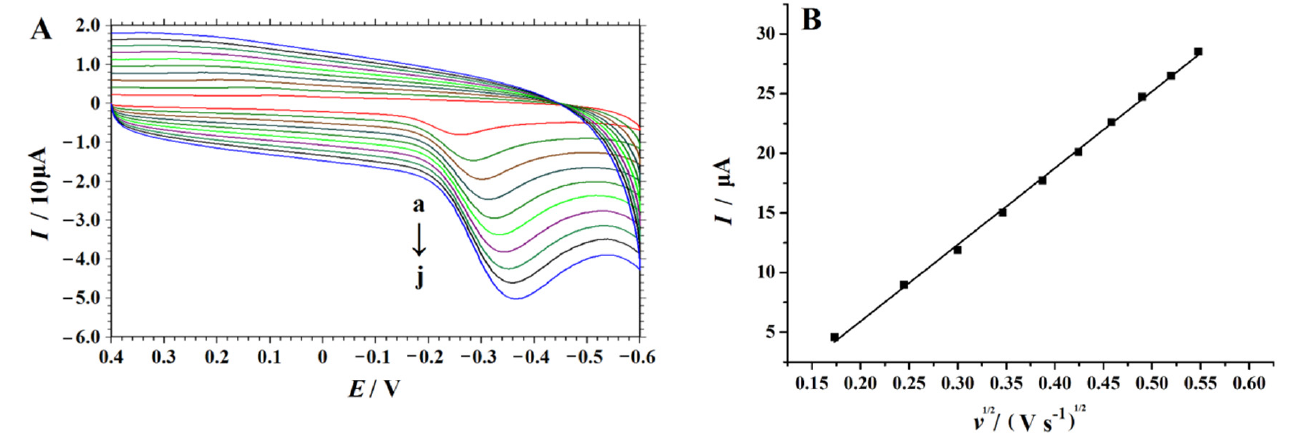
Figure 7. ( A ) Cyclic voltammograms obtained on the NC–PEI/GCE in 0.2 M H 2 SO 4 solution contain- ing 0.1 mM 4-NP under different scan rates (from a to j are 0.03, 0.06, 0.09, 0.12, 0.15, 0.18, 0.21, 0.24, 0.27 and 0.3 V s − 1 ) after accumulating at 0.2 V for 30 s, ( B ) Linear relationship fitting between I p and v 1/2 .